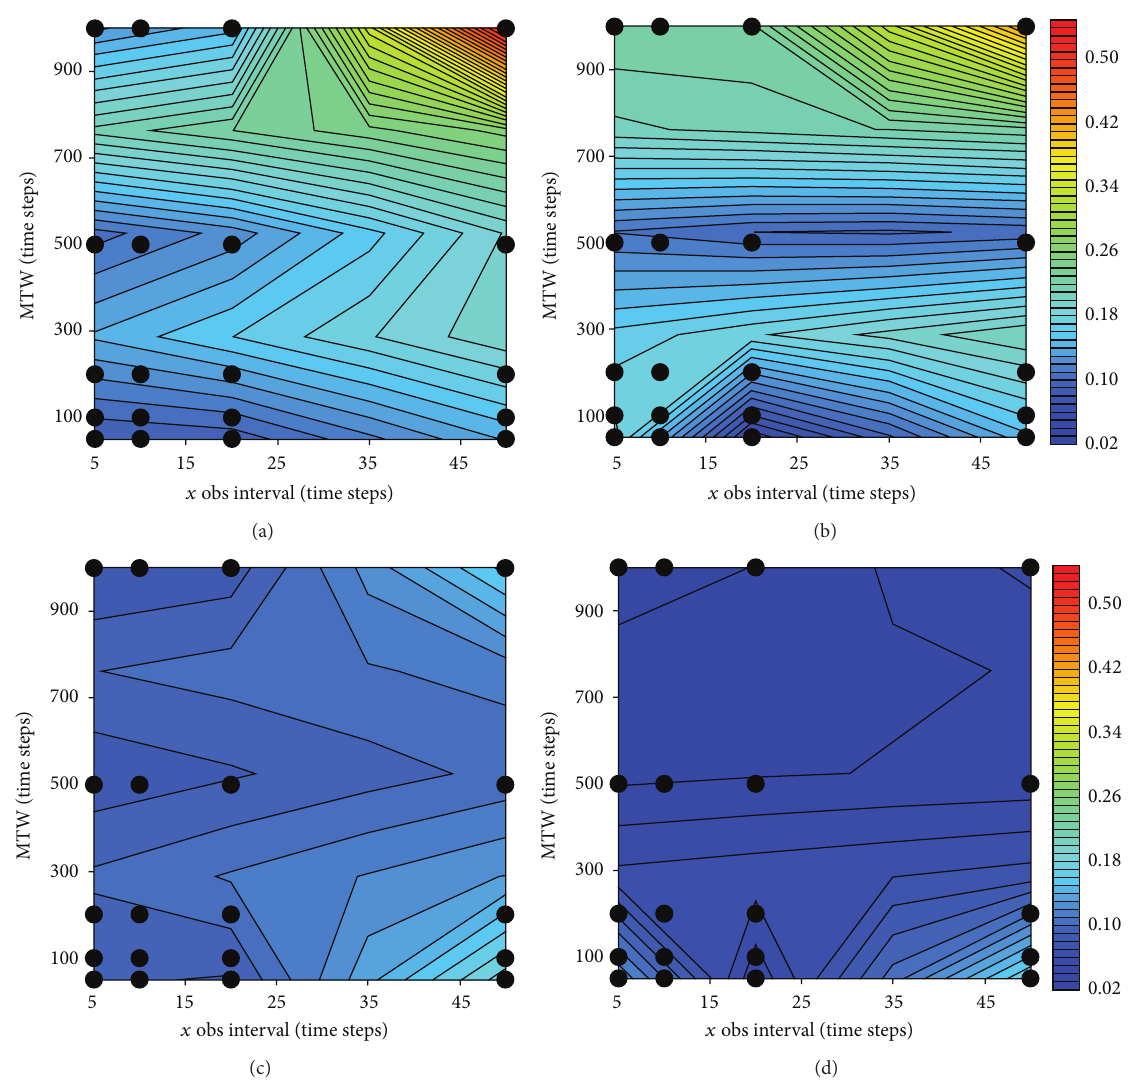
Figure 5: Same as Figure 4 but for 𝑐 2 𝑥 2 . The absolute error of 𝑐 2 𝑥 2 is normalized by its climatological standard deviation (14.5).